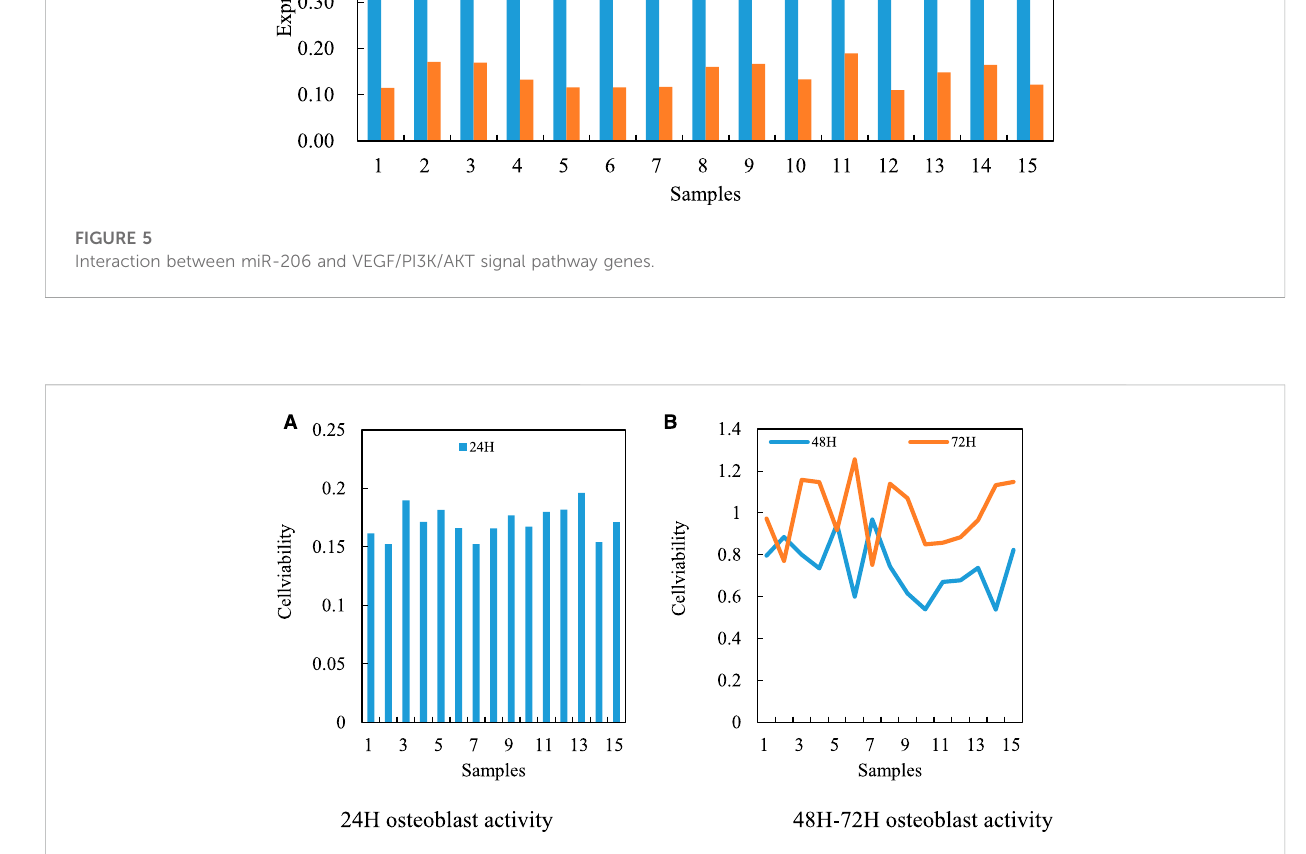
FIGURE 6 Regulation of miR-206 expression level on osteoblast activity. (A) 24H osteoblast activity (B) 48H – 72H osteoblast activity.